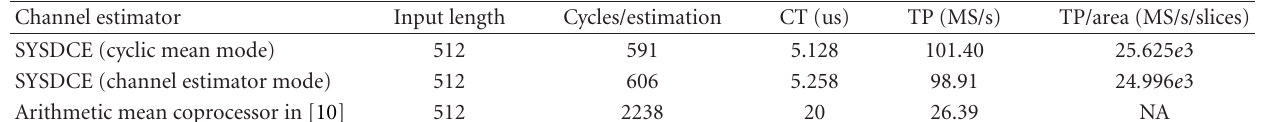
Table 3: Channel estimator throughputs comparison.